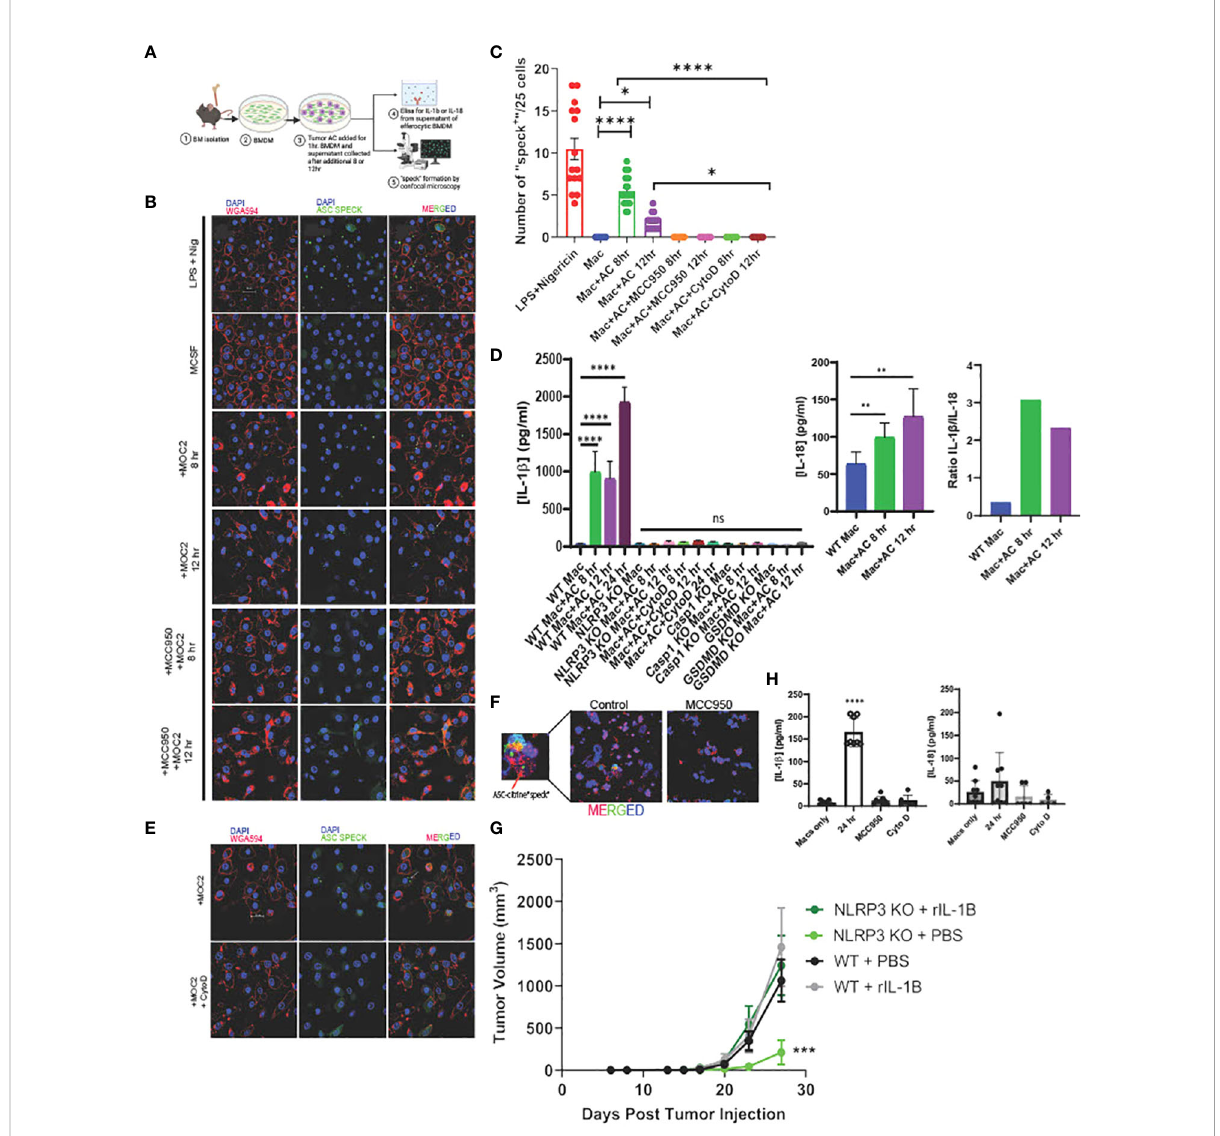
FIGURE 2 Efferocytosis induces in fl ammasome assembly and IL-1 b production in macrophages in NLRP3-dependent manner. (A) Schema of efferocytosis induced in fl ammasome activity using ASC Citrine/LysMCre BMDM. (B) Efferocytosis of tumor AC induces in fl ammasome “ speck ” formation in BMDM in a time dependent manner. BMDM from ASC Citrine/LysMCre mice were incubated with AC for 1hr. Non-engulfed AC were then washed off and “ speck ” formation was assessed using confocal microscopy at mentioned time points. BMDM were treated with 1ug/ml LPS+ 5ug/ml Nigericin (top) for four hours as a positive control. Treatment with the NLRP3 small molecule inhibitor MCC950 at a concentration of 5uM overnight abolished the effect. The fi rst panel shows macrophages (red). The second panel shows “ specks ” (green). The third panel shows merged images of macrophages with in fl ammasome “ specks ” formation. Scale bar, 20µm. (C) Graphical representation showing quanti fi cation of “ speck ” positive cells under conditions shown in (B) . (D) Graphical representation of ELISA assay showing secretion of IL-1 b and IL-18 from BMDM post treatment with AC at time points=8, 12 and 24hr. Ratio of IL-1 b and IL-18 post efferocytosis. IL-1 b was not detected post efferocytosis in NLRP3 KO BMDM or when treated with AC engulfment inhibitor Cytochalasin D at a concentration of 10uM. (E) BMDM treated with Cytochalasin D abrogated “ speck ” formation following efferocytosis. The top row represents BMDM incubated with AC. The bottom row shows BMDM treated with 10uM Cytochalasin D for 1hr prior to AC uptake. Scale bar, 20µm. (F) F4/80 + TAM (red) isolated from MOC2 tumors from ASC Citrine/LysmCre mice show in fl ammasome activation (green) in vivo . Tumor bearing mice treated with MCC950 I.P. (15mg/kg body weight) daily for fi rst three days and then every alternate day for rest of the study) failed to activate in fl ammasome “ specks ” in vivo . Inset shows magni fi ed image of TAM with in fl ammasome “ speck ” formation. DAPI was used to stain nuclei. (G) Recombinant IL-1 b treatment rescues B16- mOVA tumor growth in NLRP3 KO mice. Mice treated with 5 ng recombinant IL-1 b 2x/week (n=5 mice/group). (H) PBMC were differentiated to macrophages using 100ng/ml M-CSF for 7days and then subjected to efferocytosis with tumor AC. IL-1 b but not IL-18 is secreted from human macrophages post efferocytosis. MCC950 (5uM, overnight) and Cytochalasin D (10uM, 1hr before uptake) blocked IL-1 b secretion in efferocytic macrophages. Data for “ speck ” formation and ELISAs shown from independent experiments with n=3-5 mice. Graphs shown as mean ± SEM. (*p < 0.05, **p < 0.01, ***p < 0.001, ****p <